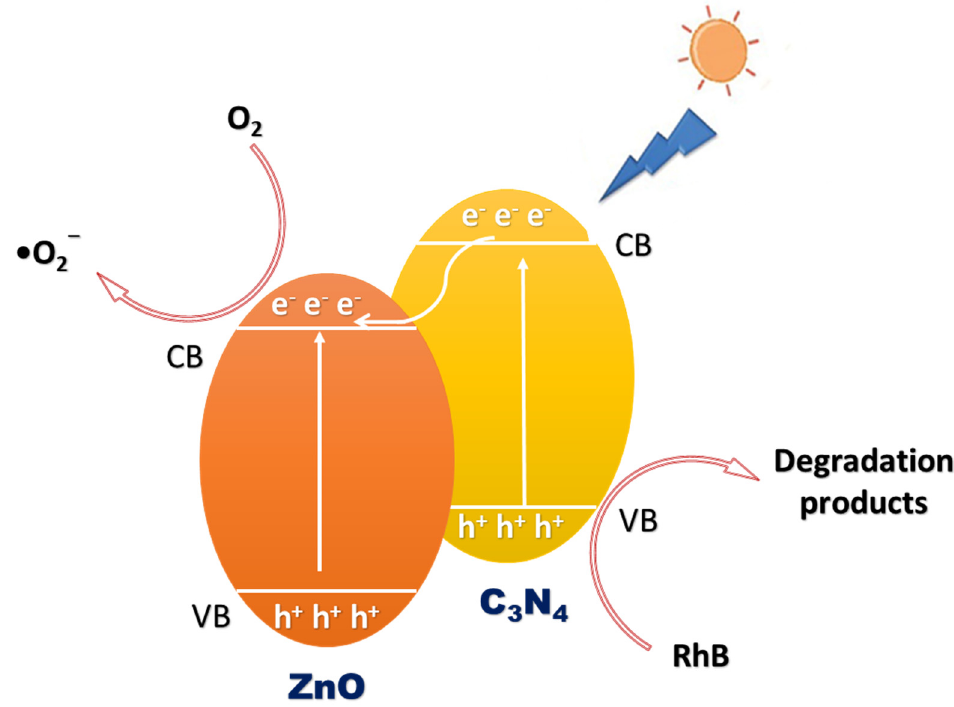
Scheme 2. Schematic design of the photoelectron transfer mechanism in ZnO/C 3 N